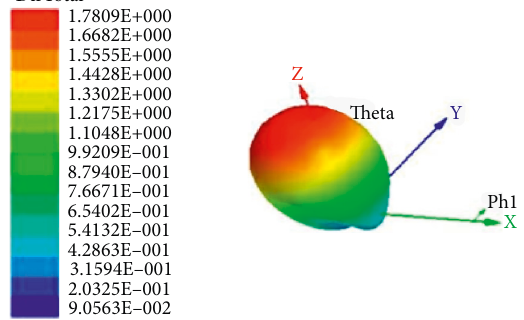
Figure 8: Directivity of designed circular patch antenna.